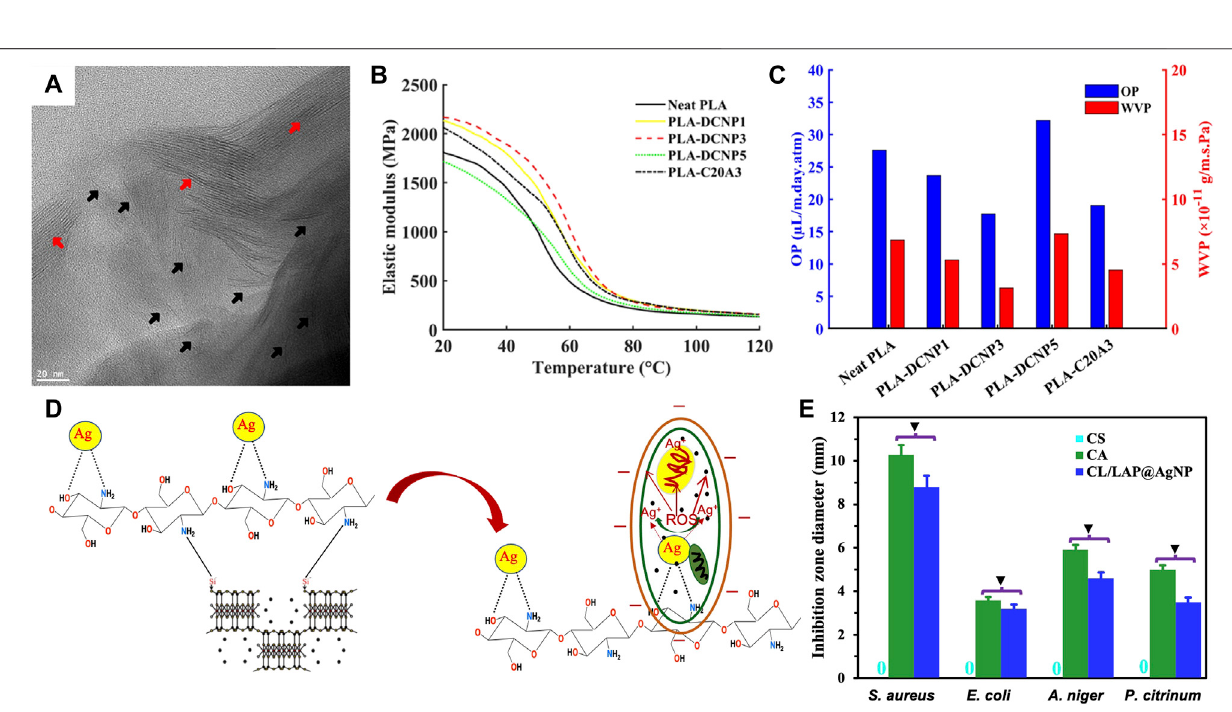
FIGURE 6 | Schematic illustrations of (A) three possible microstructures in nanoclay-polymer nanocomposites and (B) permeability mechanism of molecules through nanoclay-polymer coatings on the substrate.